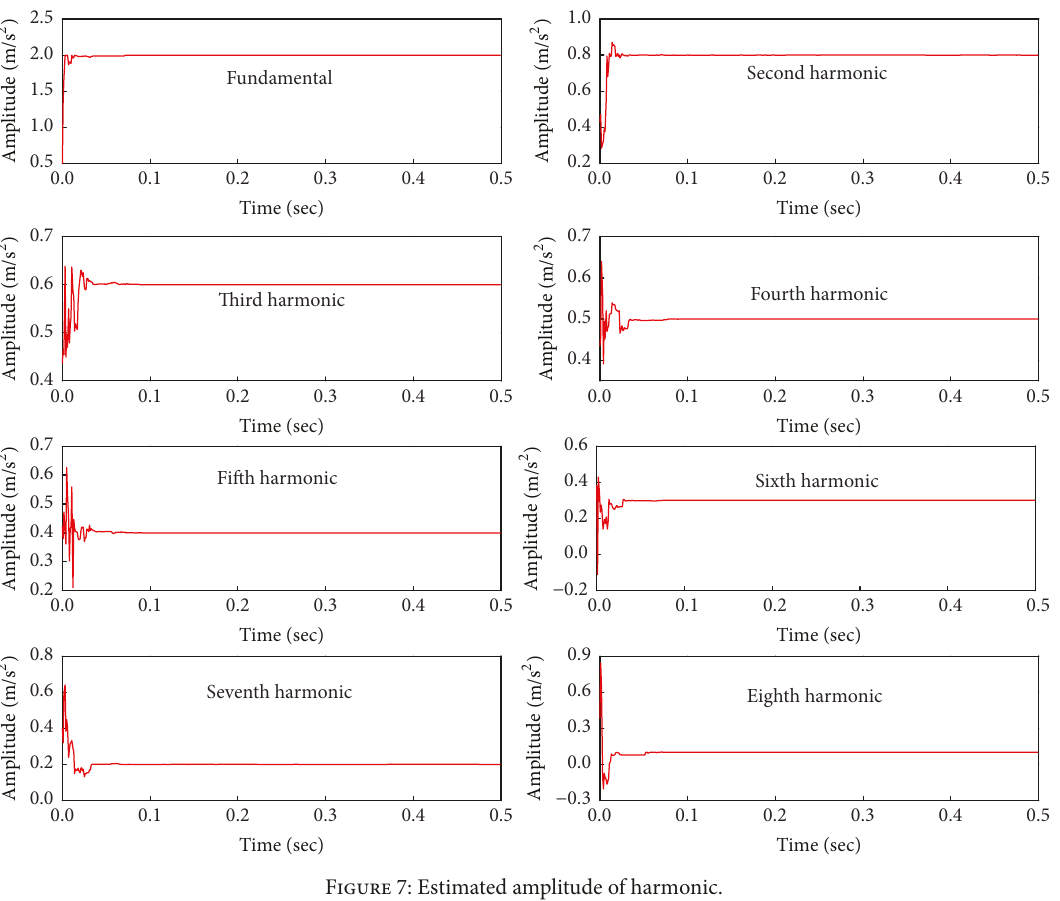
Figure 6: Structure of WCA estimation scheme.